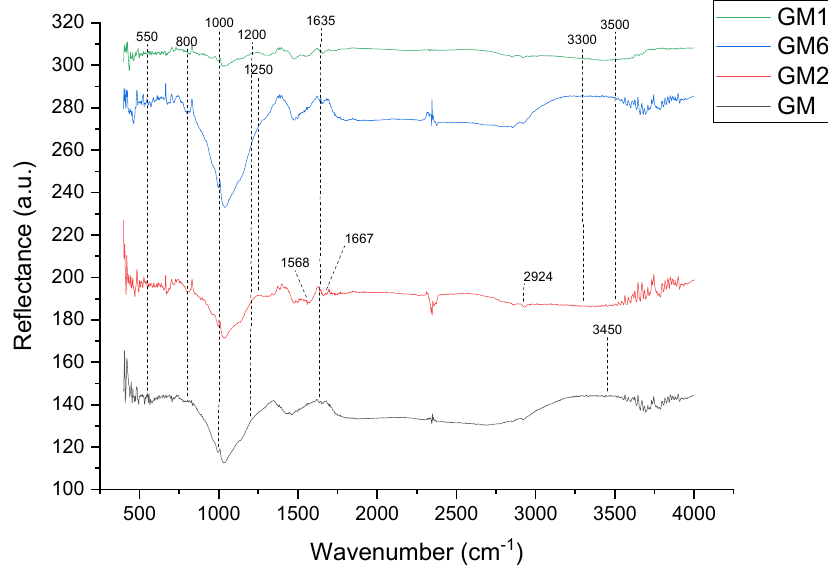
Figure 5. DRIFT spectra of GM, GM2, GM6, and GM10.